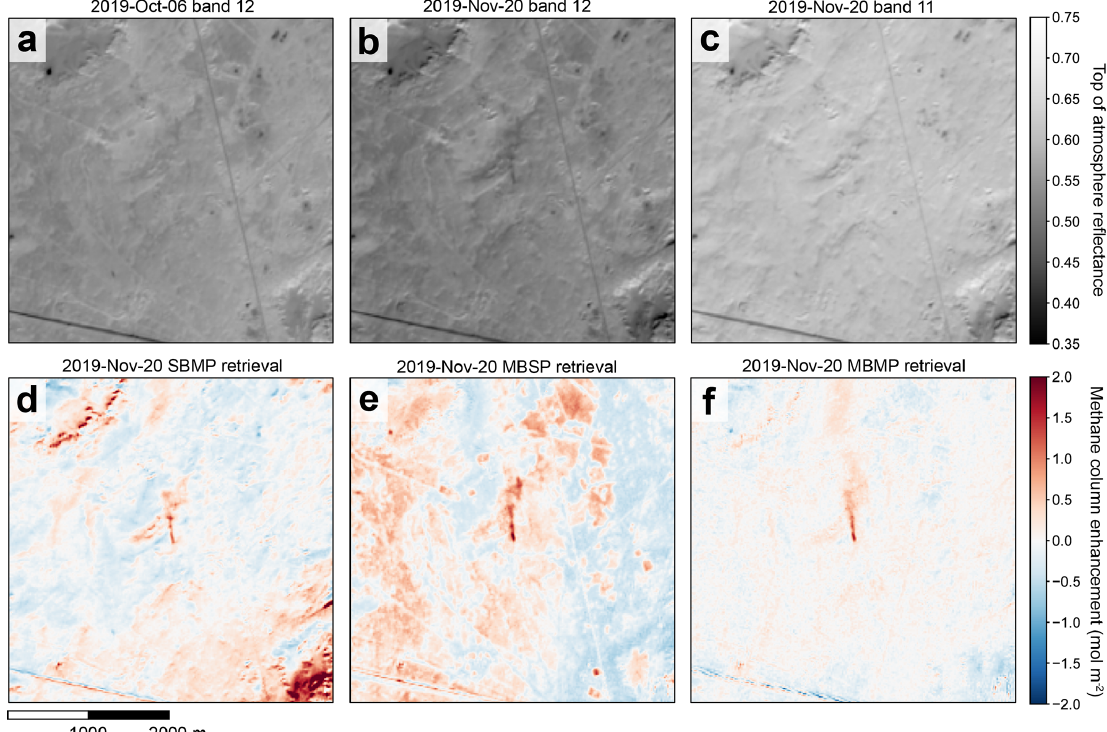
Figure 2. Demonstration of Sentinel-2 methane column retrieval for a plume emitted from a point source (31.6585 ◦ N, 5.9053 ◦ E) in the Hassi Messaoud oil field of Algeria on 20 November 2019 (see Sect. 4). (a) Sentinel-2 top of atmosphere reflectances for band 12 observed on 6 October 2019, a reference day when no plume is present. (b) The same as panel (a) , but for 20 November 2019 when the plume is present in the middle of the image. (c) Top of atmosphere band-11 reflectances corresponding to panel (b) . (d) Single-band–multi-pass (SBMP) retrieval for 20 November 2019. (e) The same as panel (d) but for the multi-band–single-pass (MBSP) retrieval. (f) The same as panel (d) but for the multi-band–multi-pass (MBMP)